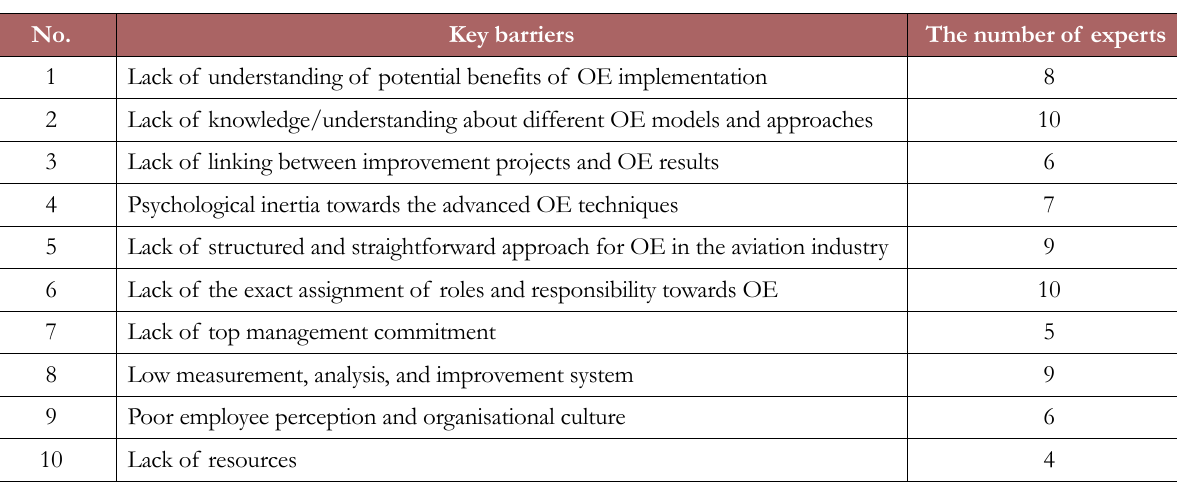
Table 2. The Analysis of Crucial Barriers Affecting the Achievement of OE in the Sudanese Aviation Industry All the members from the expert panel responded to the Delphi round 1 study. Generally, they agreed with the five CSFs categories for achieving OE in the Sudanese aviation industry. However, the selected experts provided suggestions concerning level two and level three of the study. As a result, changes were made, and the structure of CSFs was revised according to their suggestions, as shown in Figure